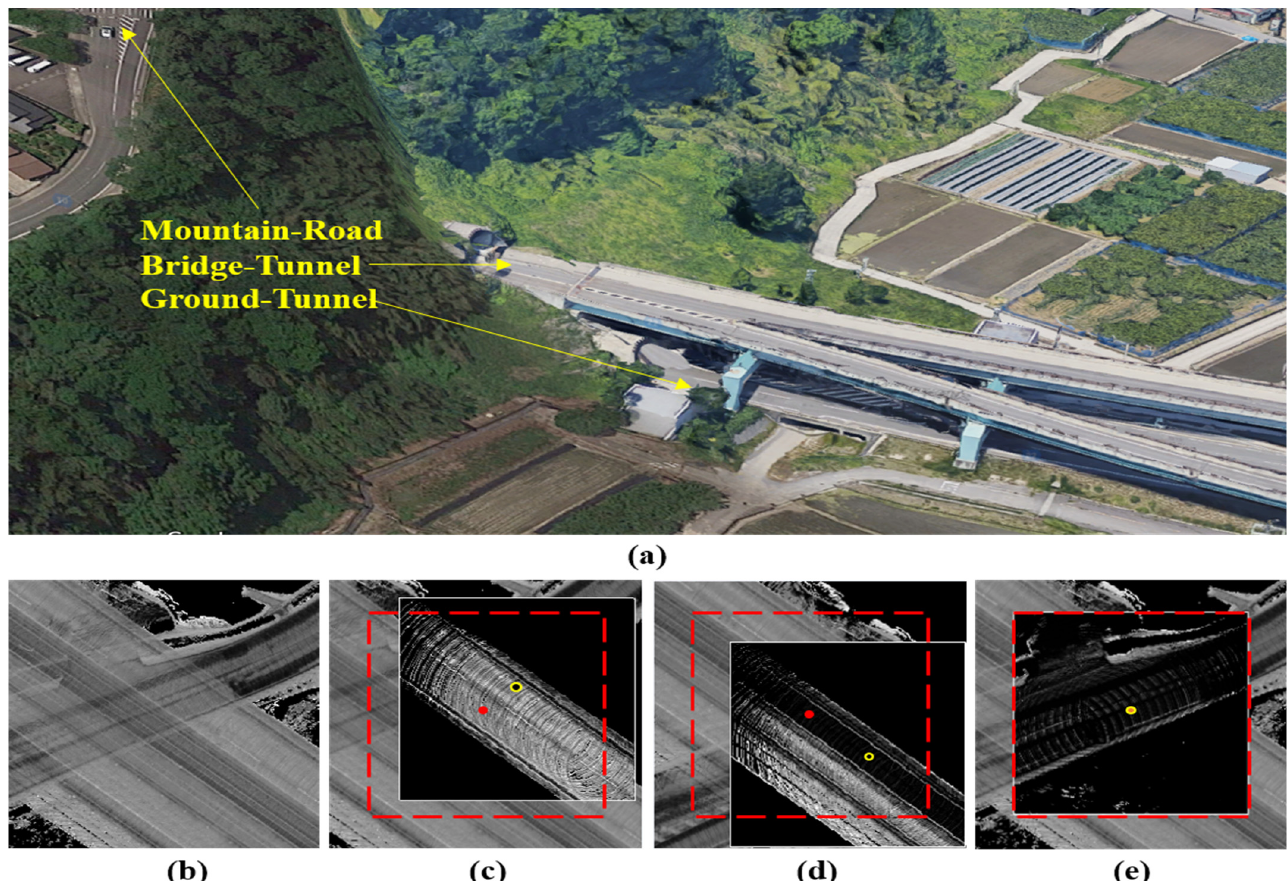
Figure 2. ( a ) Multilevel environment consisting of three layers: ground-tunnel, bridge-tunnel and mountain surface. ( b ) The three layers are accumulated in the same map image [8]. ( c – e ) Map image in ( b ) overlapped by LIDAR image based on the matching score in the three layers, respectively. Red circle and rectangle show the accurate actual location whereas yellow circle indicates the estimated position.